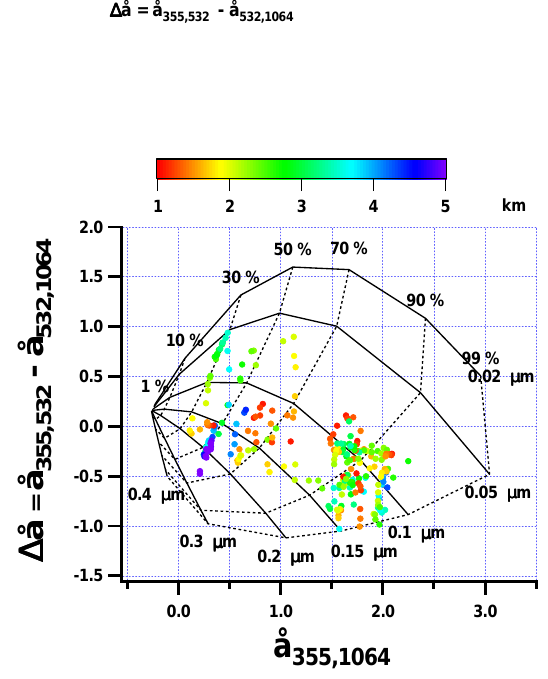
Fig. 17. Scatter plot of 1 å (z) vs. å 355 , 1064 (z) retrieved from the lidar measurements performed during 10 measurement days. Dif- ferent colours are used to represent different altitudes